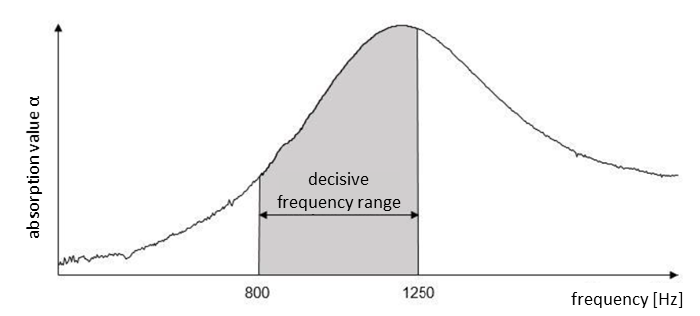
Figure 4. Decisive frequency